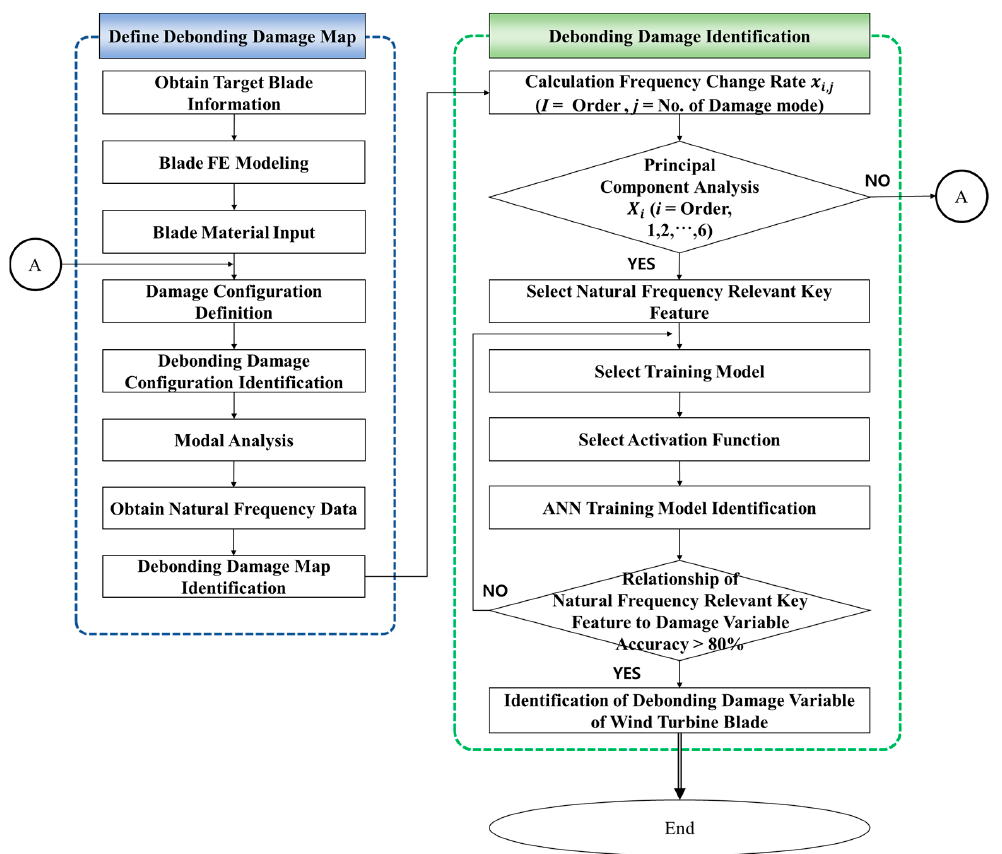
Figure 1. Flow chart for identifying debonding damage in a wind turbine blade.